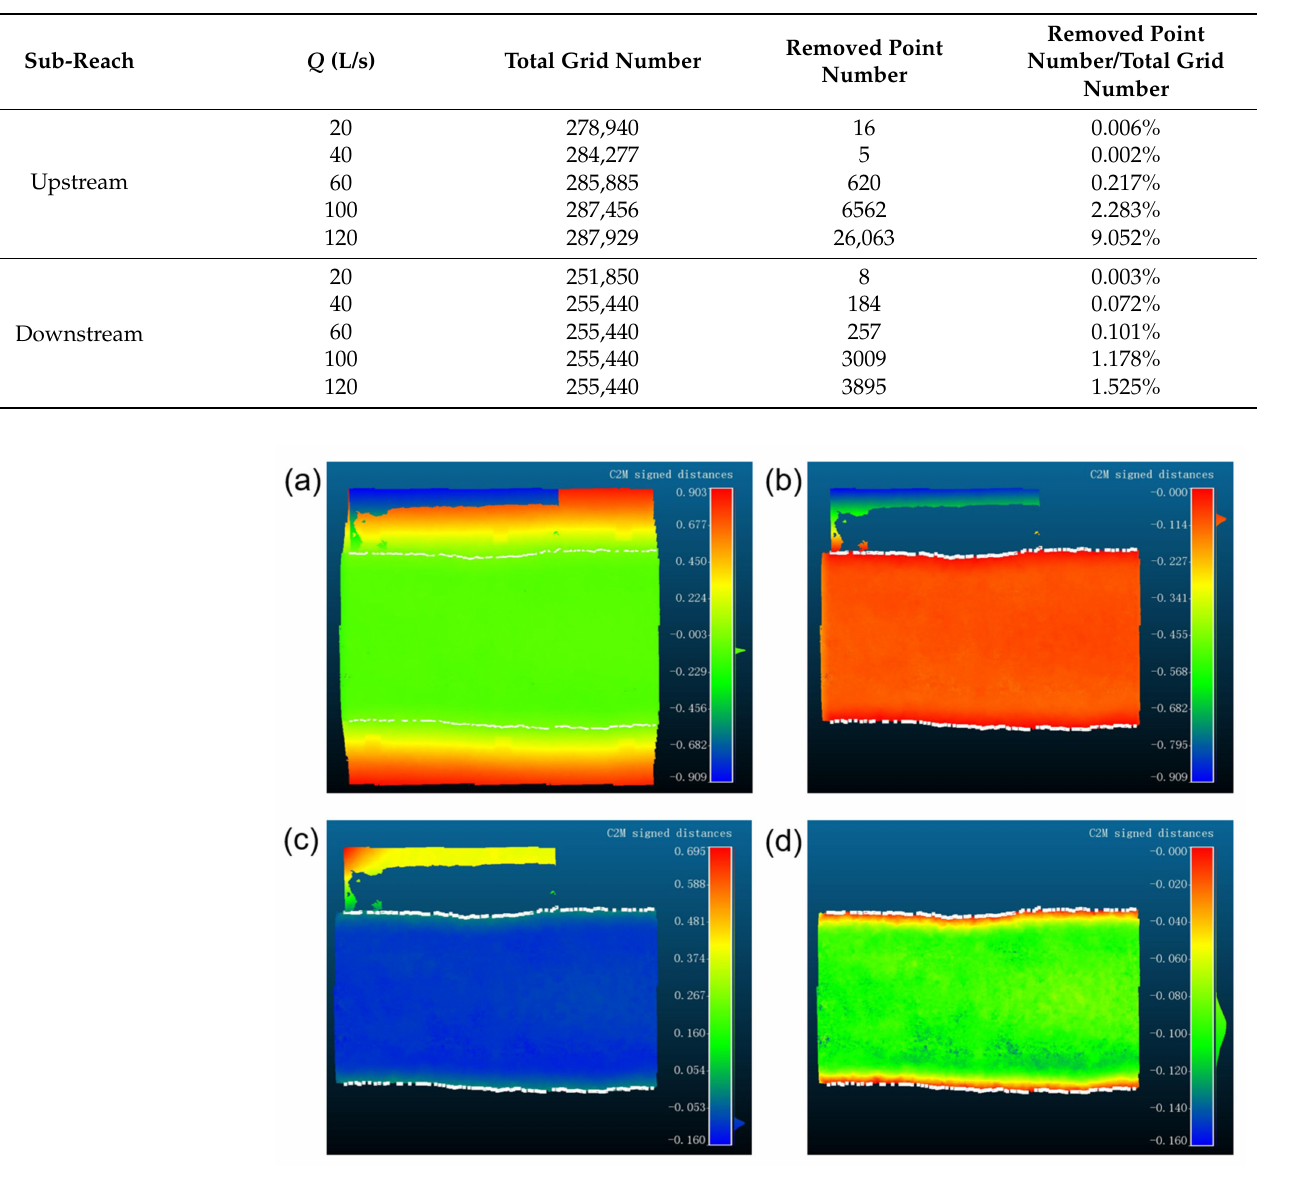
Figure A1. The procedure of resampling the underwater points in the dense clouds for the model for MR1 at Q = 20 L/s: ( a ) cloud-to-mesh (C2M) distance between the rasterized dense cloud and the water surface mesh; ( b ) filtered dense cloud with C2M distance ≤ 0; ( c ) new C2M distance between the filtered dense cloud in ( b ) and the fitting plane for water edge points; ( d ) filtered dense cloud with the new C2M distance ≤ 0. The white points in each panel are the water edge